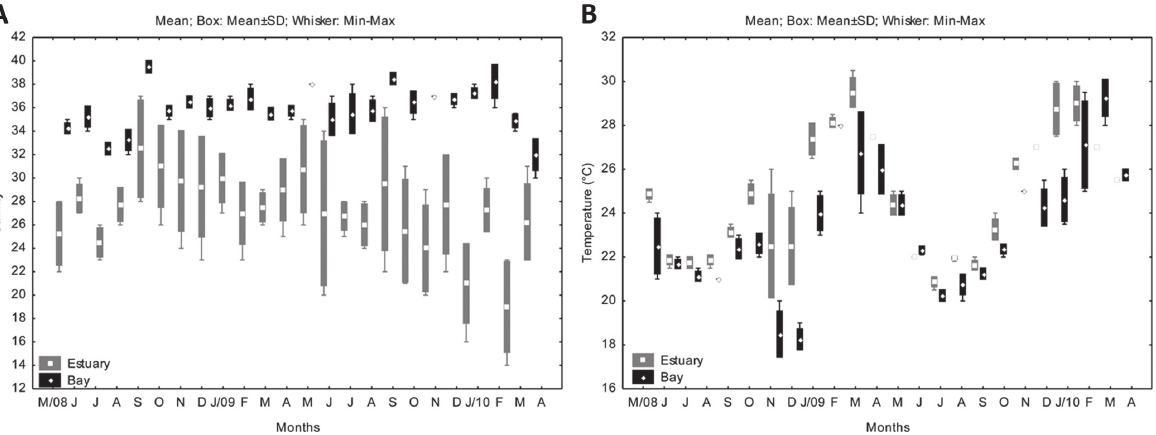
Fig. 2 - The mean, standard deviation, maximum and minimum values of (A) salinity and (B) temperature (°C) recorded from May 2008 through April 2010 in the sample locations in the Santos Bay and the São Vicente